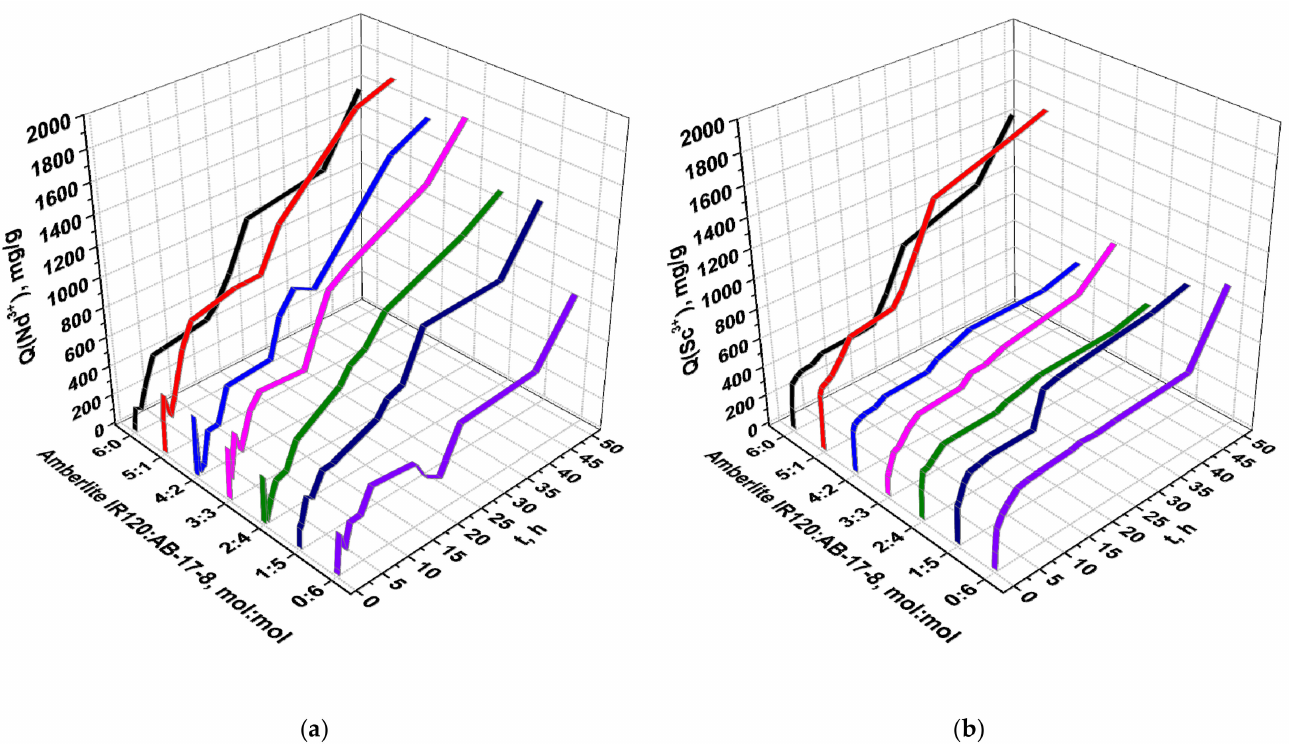
Figure 7. Effective dynamic exchange capacity (in relation to Nd 3+ ( a ) and Sc 3+ ( b ) ions) of interpolymer system, Amberlite